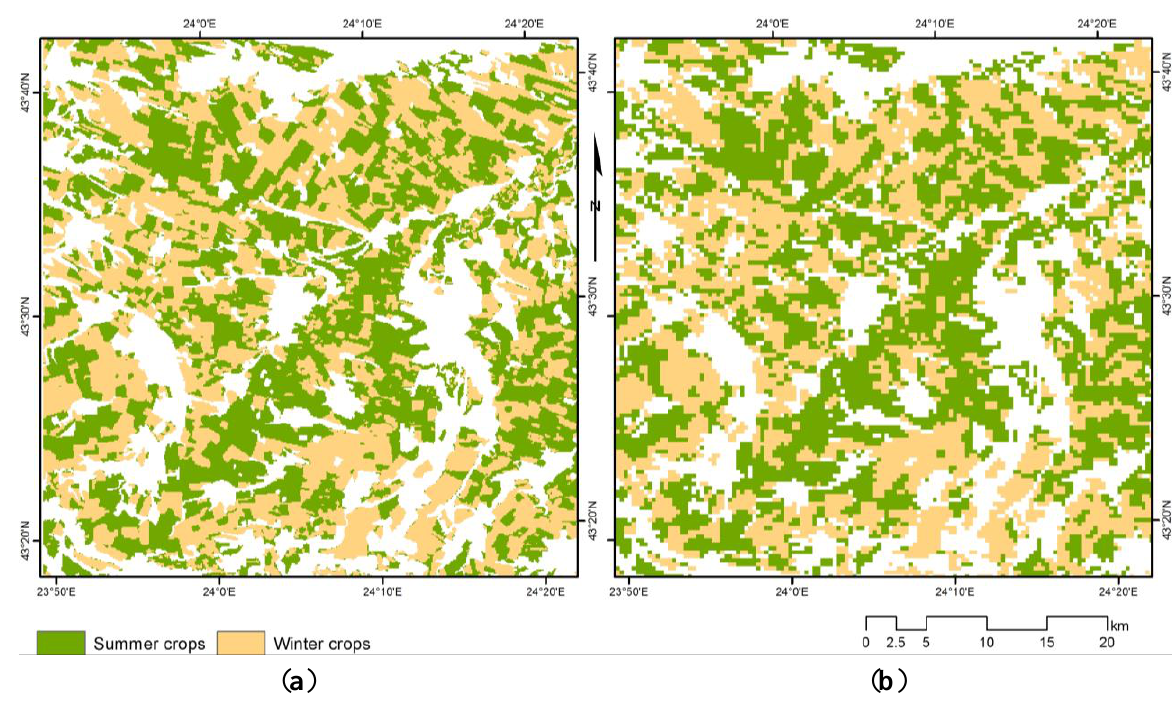
Figure 7. Crop map with two classes from unsupervised ISODATA clustering for ( a ) 100 m and ( b ) 300 m PROBA-V NDVI time series. Note that areas outside the CORINE class 211 (agriculture) were left